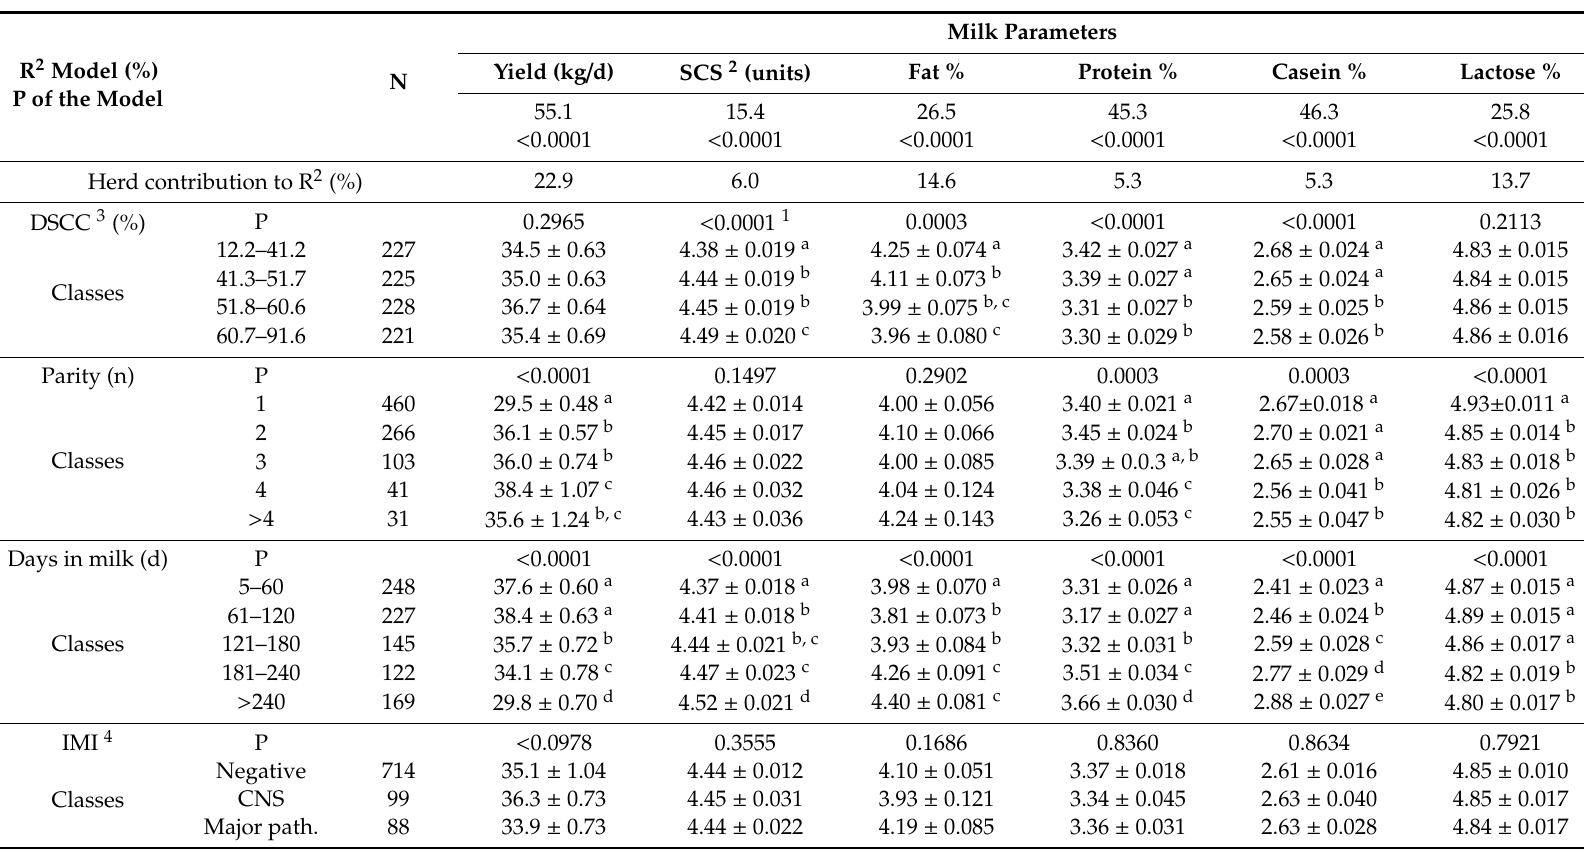
Table 6. Analysis of variance results and least square means ± standard error of the mean calculated by a general linear model for milk yield, SCS and milk components.